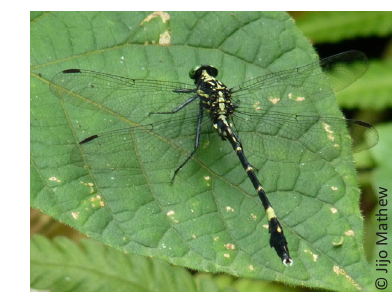
Image 5. Megalogomphus hannyngtoni